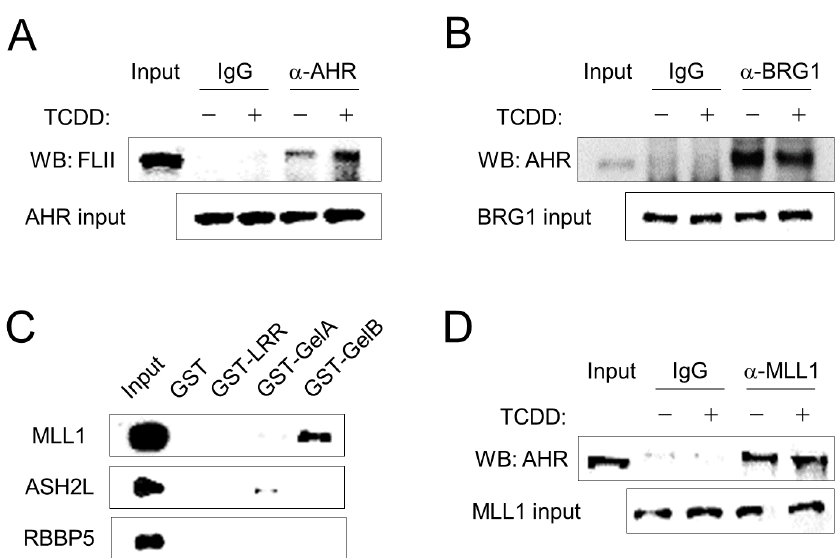
Figure 2. FLII interacts with AHR and MLL1 in ARPE-19 cells. ( A ) Co-immunoprecipitation was performed with total extracts from ARPE-19 cells. Cells were treated with either 10 nM TCDD or vehicle (toluene). One hour later, cells were harvested and total cellular protein was extracted with RIPA buffer. Immunoprecipitation was performed using normal IgG or an anti-AHR antibody. Immunoblotting was performed using an anti-FLII antibody. ( B ) AHR binding to BRG1. Immunoprecipitation was performed using normal IgG or an anti-BRG1 antibody. Immunoblotting was performed using an anti-AHR antibody. ( C ) In vitro protein-binding assay. GST-fused LRR, GelA or GelB domains of FLII expressed in E. coli were immobilized on glutathione agarose beads and then incubated with ARPE-19 cell lysates for 24 h. Bound MLL1, ASH2L or RBBP5 were analyzed by western blotting using specific antibodies. ( D ) AHR binding to MLL1. Immunoprecipitation was performed using normal IgG or an anti-MLL1 antibody. Immunoblotting was performed using an anti-AHR antibody.